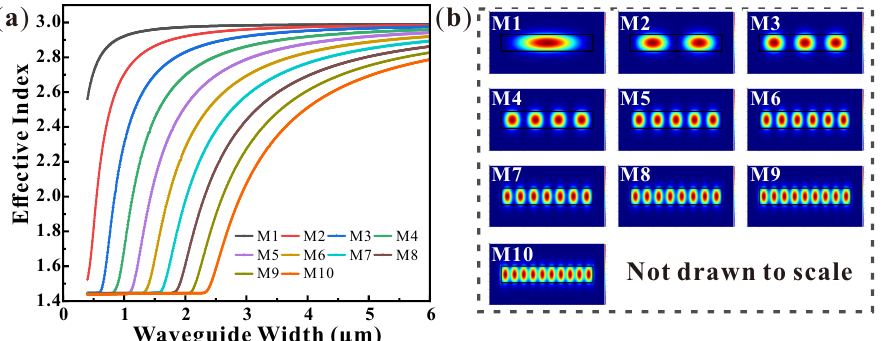
Figure 2. ( a ) Effective index of the first 10 modes in waveguide versus waveguide width. ( b ) Mode profiles of the first 10 modes in a waveguide with 4 µ m width.